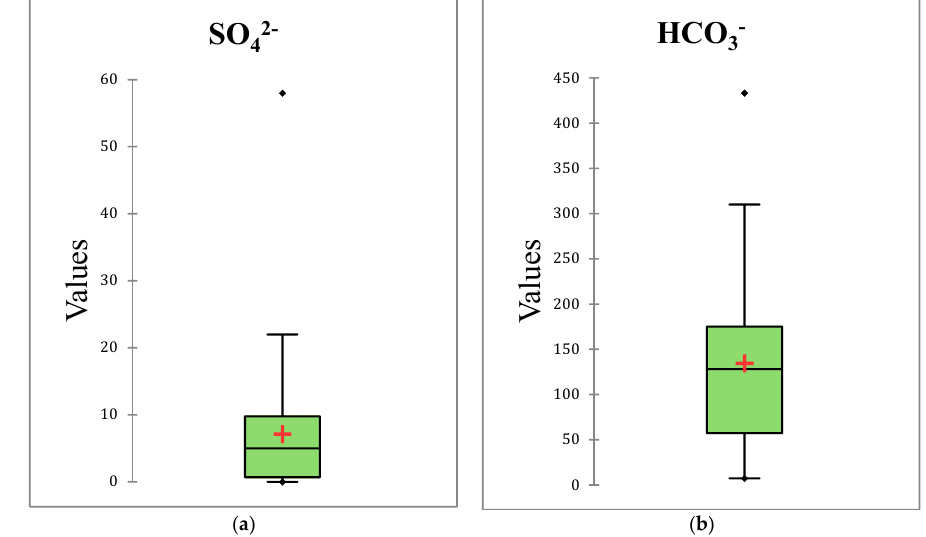
Figure 5. a )Sulfate SO 42- variation. b ) HCO 3 − variation. Figure 5. ( a ) Sulfate SO 42 − variation. ( b ) HCO 3 −